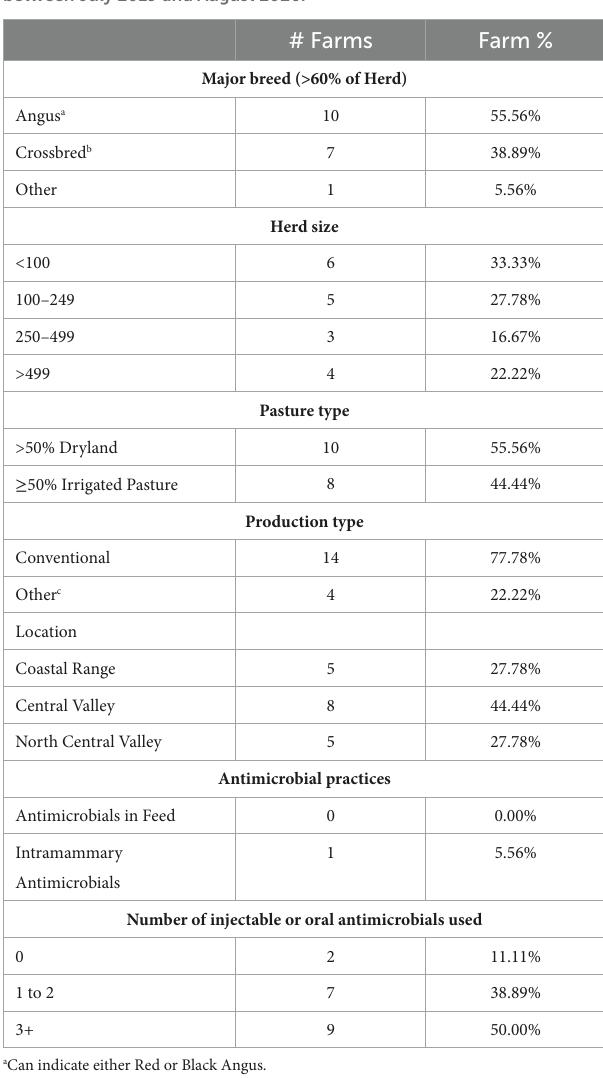
TABLE 2 Descriptive survey data from all farms sampled in a study on prevalence of antimicrobial resistant E. coli and Enterococcus in fecal samples from cow-calf operations in northern California collected between July 2019 and August